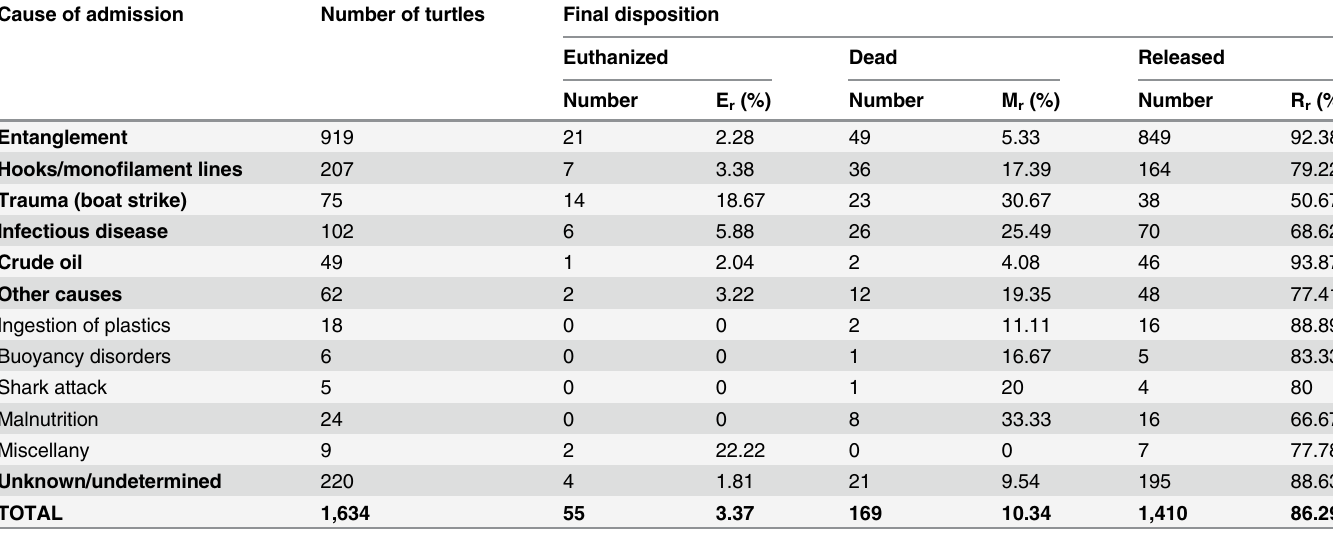
Table 2. Final disposition of the loggerhead turtles admitted alive during the period 1998 –